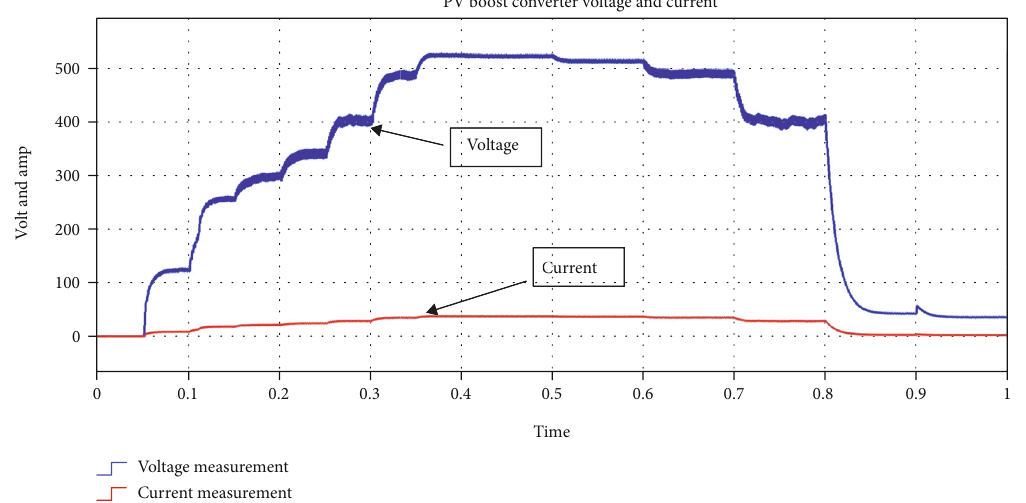
Figure 10: Simulation results of DNN-PV MPPT boost converter voltage and current with respect to irradiance and temperature.